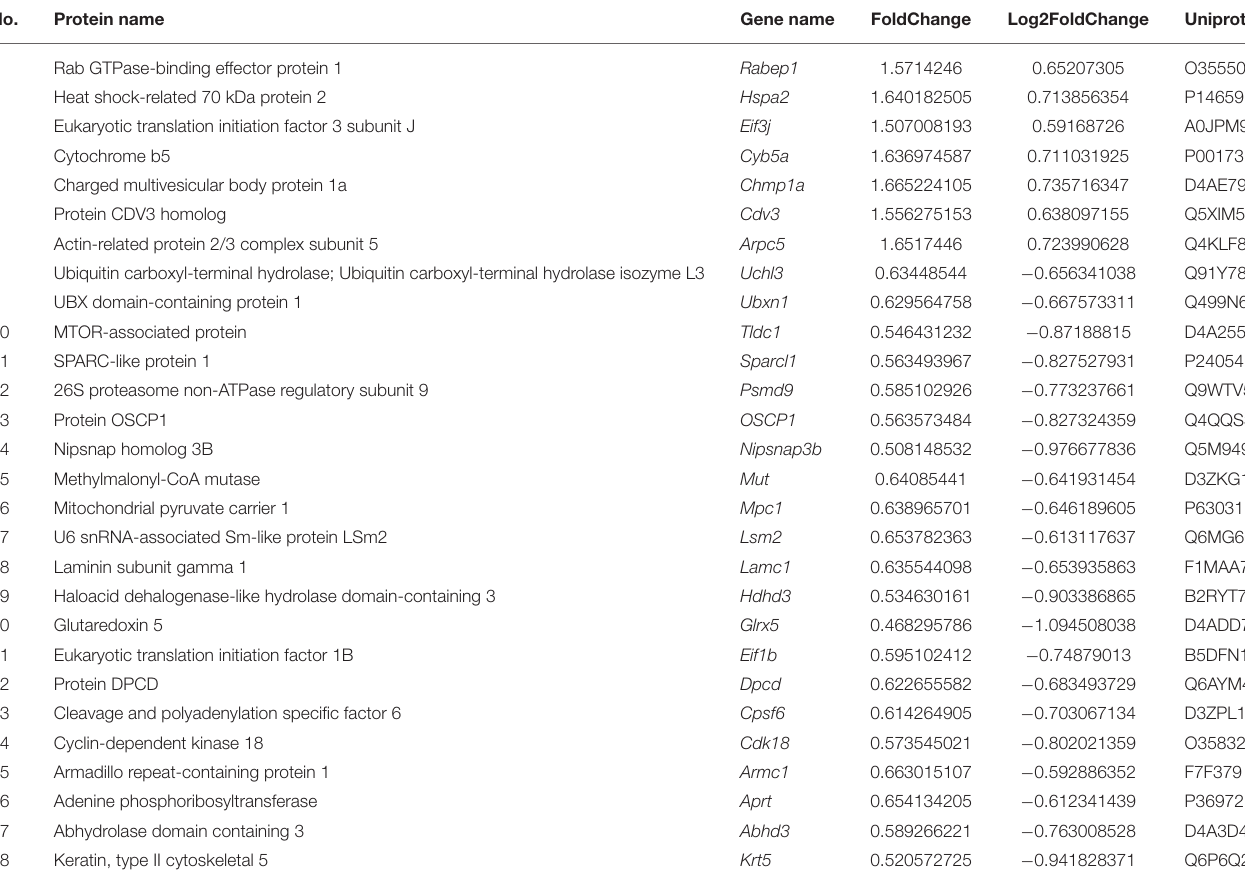
TABLE 4 | GO annotation list of significantly different proteins ( n = 3).